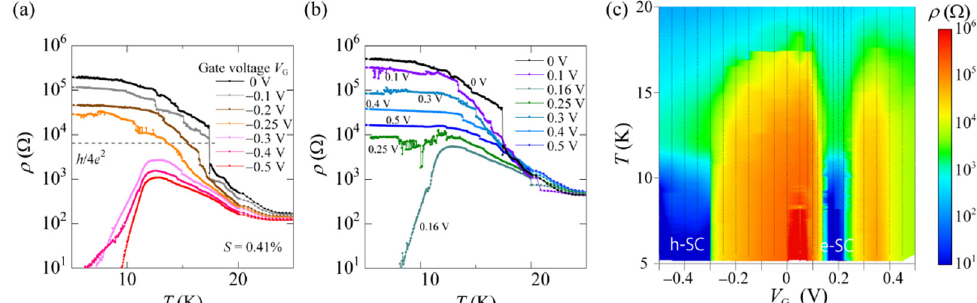
Figure 6. Sheet resistivity vs. temperature plots under ( a ) hole doping and ( b ) electron doping at tensile strain S = 0.41%. The dashed line indicates pair quantum resistance ℎ/4𝑒 (cid:2870) . ( c ) Contour plots of the data in ( a , b ). h-SC and e-SC denote hole-doped superconductor and electron-doped superconductor, respectively.